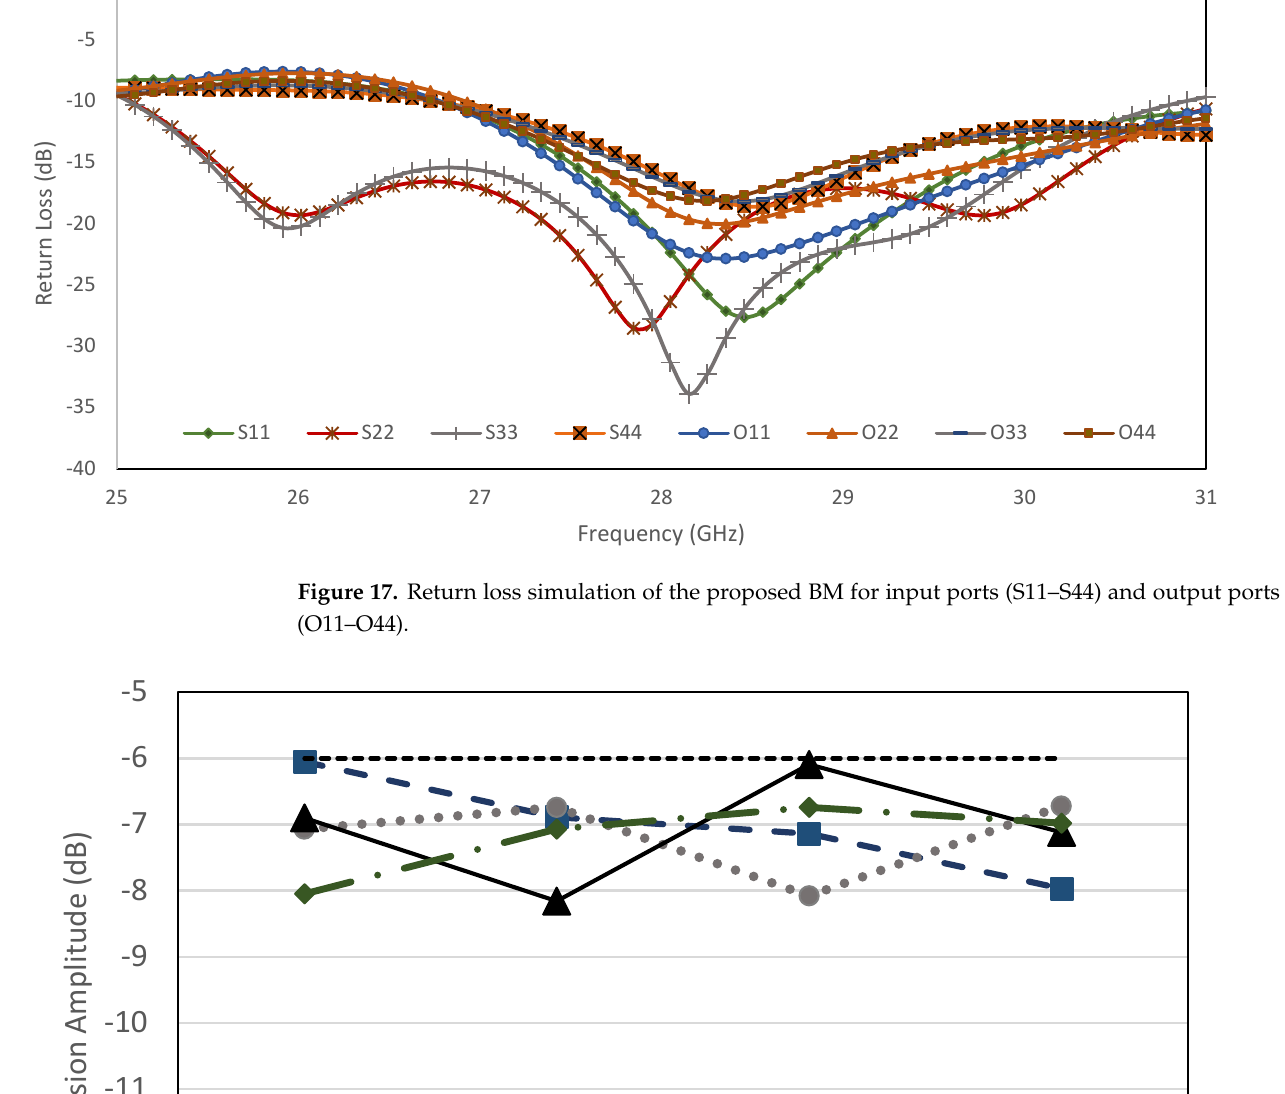
Figure 19. Output phase difference of the BM. Table 3. Simulated transmission amplitude of the via-hole BM in dB. Transmission Amplitude of the Via-Hole BM (Internal Design) (dB) P1